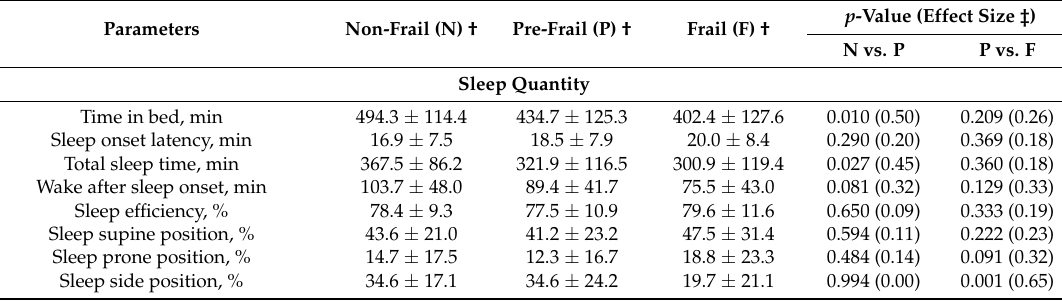
Table 2. Results of sensor derived parameters assessment, stratified by frailty status.